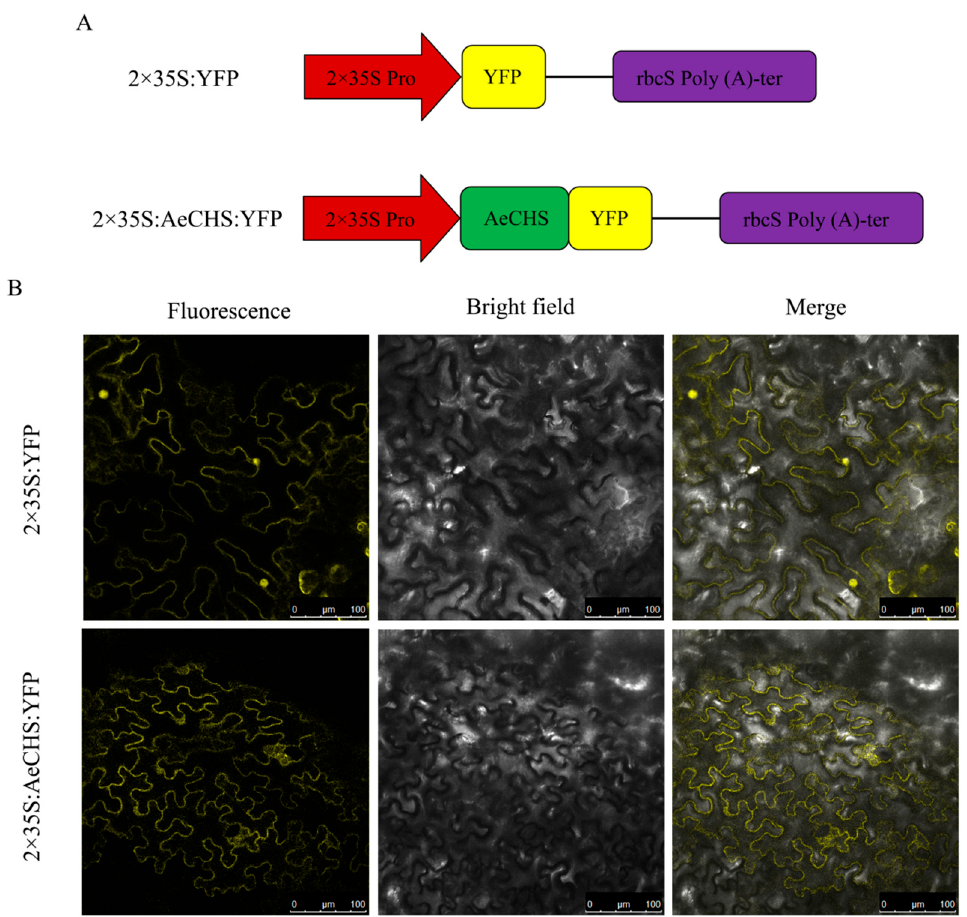
Figure 6. Subcellular localization. ( A ) Vector construction of 2 × 35S:YFP and 2 × 35S:AeCHS:YFP. ( B ) Subcellular localization of AeCHS in Nicotiana benthamiana leaves. Experiments were repeated three times. Cells expressing AeCHS:YFP fusion gene showed fluorescence in cytoplasm. Cells expressing empty plasmid with YFP tag was used as a control.